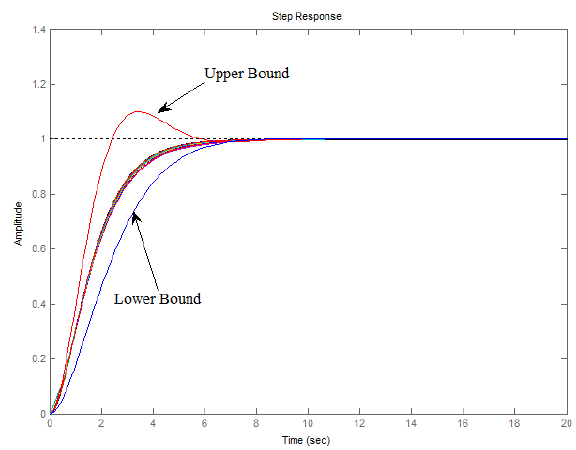
Figure 16. Step response of the system for vertical motion